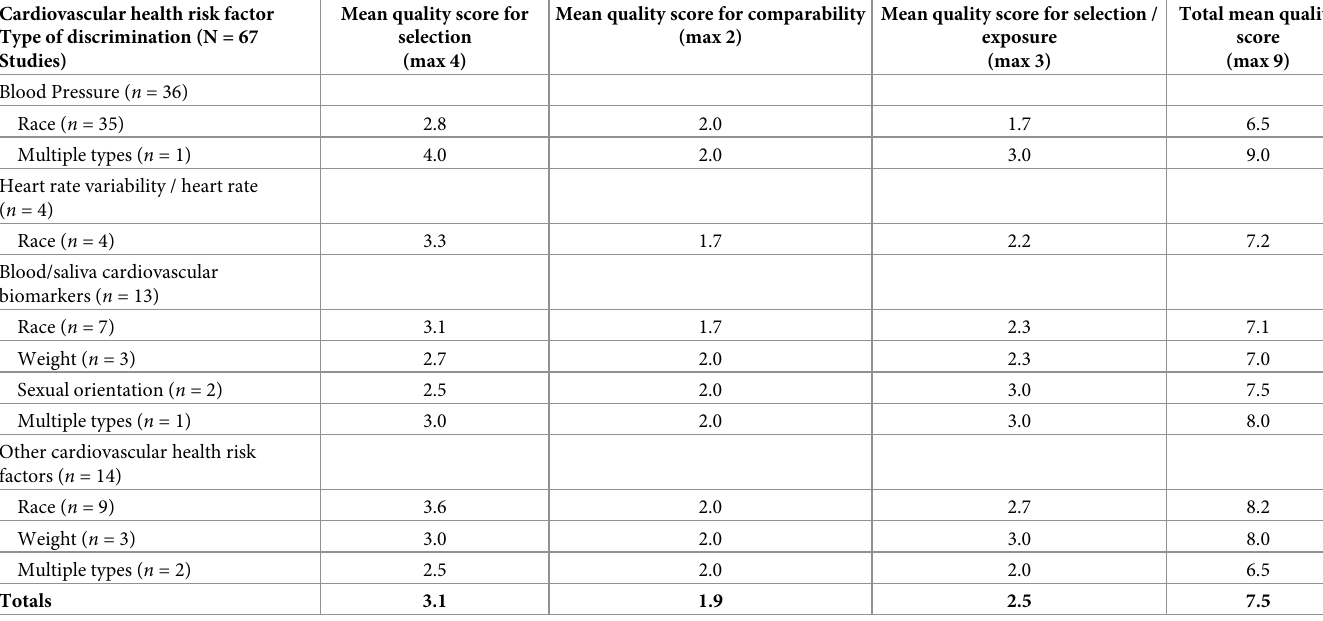
Table 3. Summary of study quality scores of the included cross-sectional and longitudinal cohort studies assessed by the Newcastle-Ottawa Scale